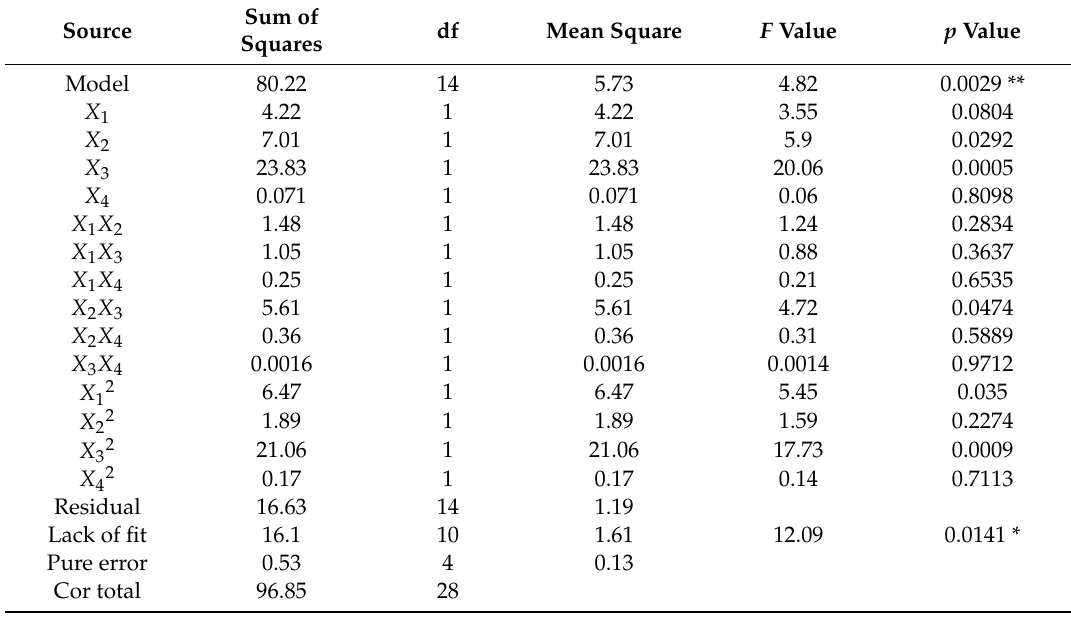
Table5. ANOVAforthefittedquadraticpolynomialmodelfortheoptimizationofextractionparameters. Sum of df Mean Square F Value p Value Source Squares Model 80.22